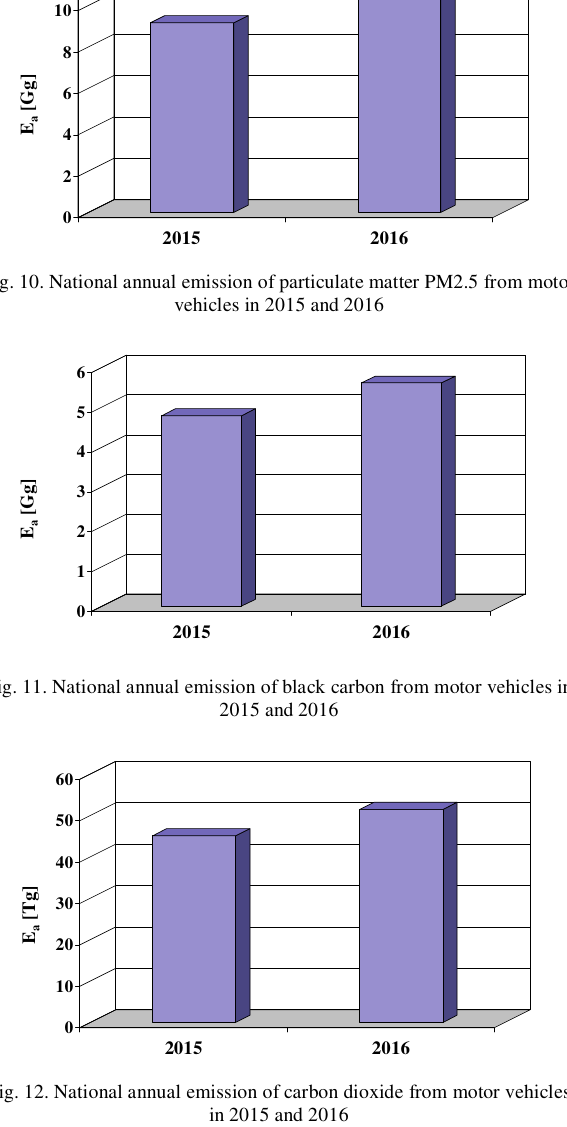
Fig. 12. National annual emission of carbon dioxide from motor vehicles in 2015 and 2016